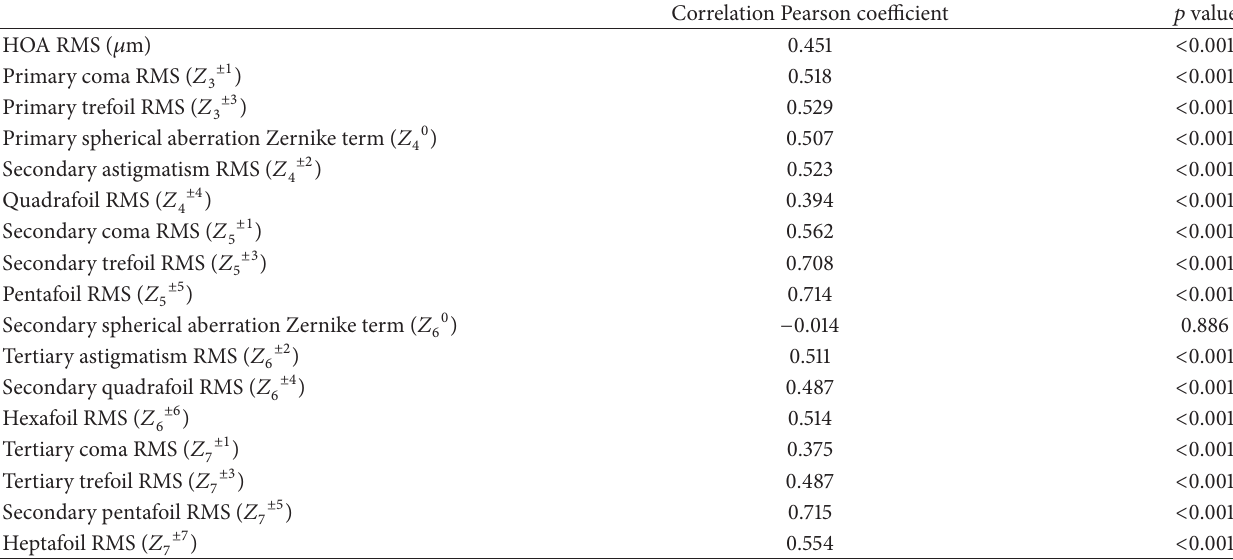
Table 5: Summary of correlations between different corneal aberrometric parameters and their within-subject standard deviation ( 𝑆 𝑤 )